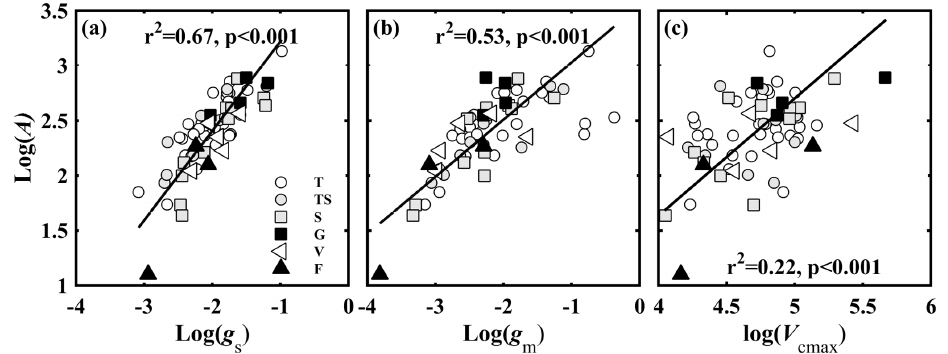
Figure 3. Relationships between light-saturated net photosynthesis ( A , µmolCO 2 m − 2 s − 1 ) and (a) stomatal conductance to CO 2 ( g s , molCO 2 m − 2 s − 1 ) ; (b) mesophyll conductance to CO 2 ( g m , molCO 2 m − 2 s − 1 ) ; and (c) the maximum carboxylase activity of Rubisco ( V cmax , µmolCO 2 m − 2 s − 1 ) . Lines refer to regression line for 63 species. T, TS, S, G, V, and F represent tree, tree/shrub, shrub, grass, vine, and fern, respectively.